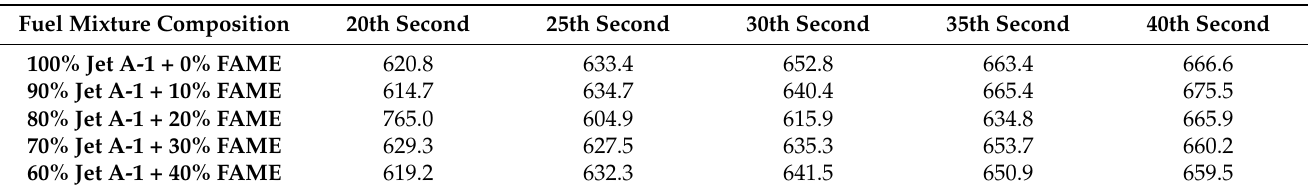
Table 17. Change in total gas temperature during gas expansion on gas turbine Δ t PT [°C] SJE-20 with different concentrations of Jet A-1 aviation kerosene and FAME biofuel.